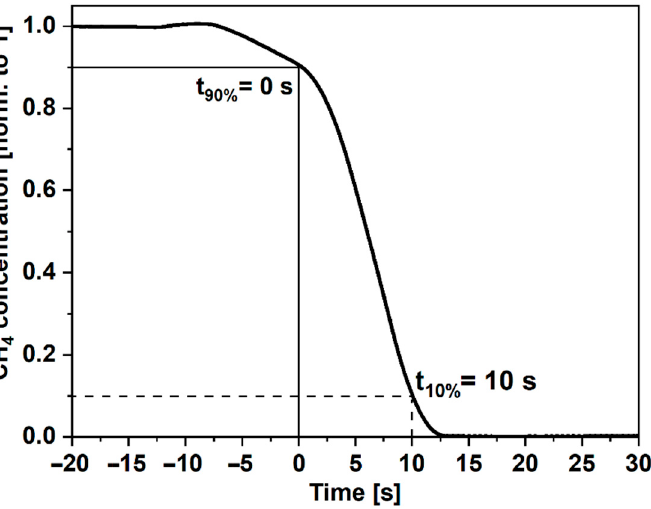
Figure 4. Gas exchange time measured for N 2 pressured through the fiber with 25 Torr overpressure.